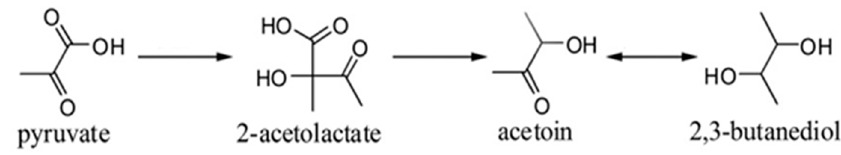
Figure 6. Scheme of acetoin and 2,3-butanediol biosynthetic pathway [34].